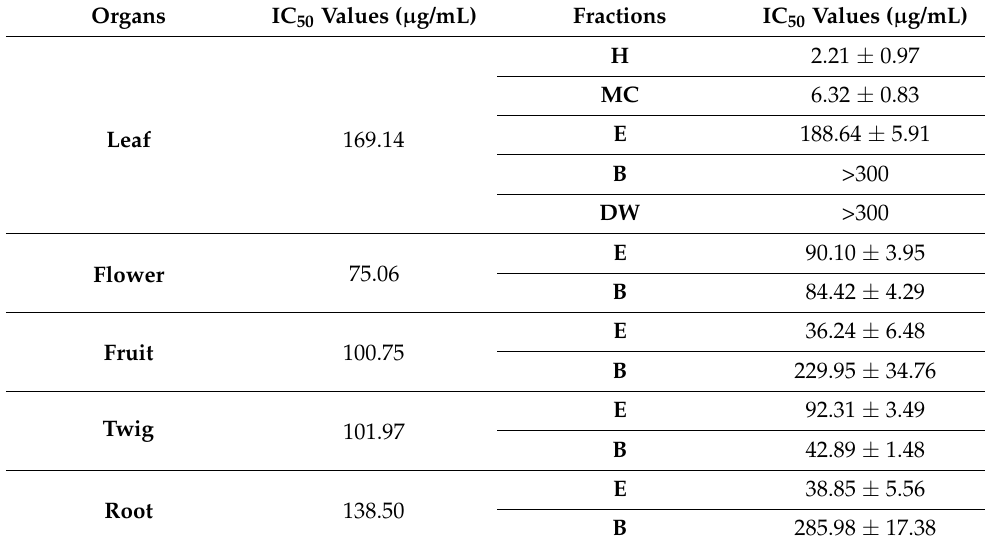
Table 5. Anti-inflammatory activity of organ extracts and their fractions in LPS-stimulated RAW264.7